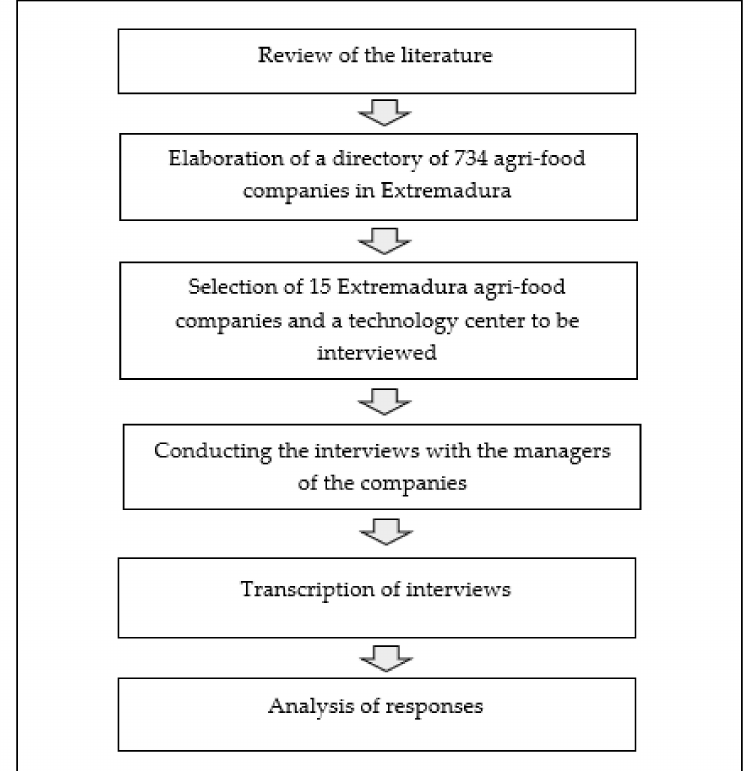
Figure 1. Research